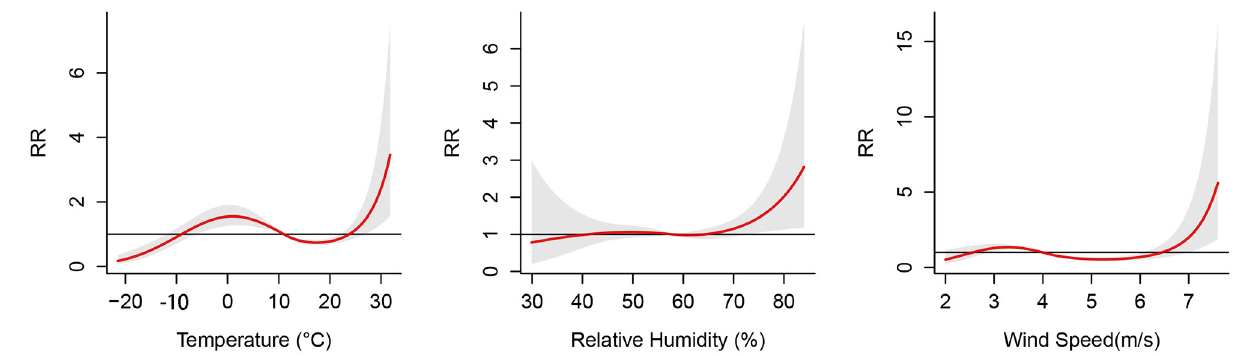
FIGURE 4 | Lag-response curves for P1, P5, P95, P99 of meteorological variables on PTB. P1, the 1th percentile; P5, the 5th percentile; P95, the 95th percentile; P99, the 99th percentile. The median value was reference. Red asterisk and blue asterisk indicate the mean relative risk, and the black vertical line corresponds to 95%CI.